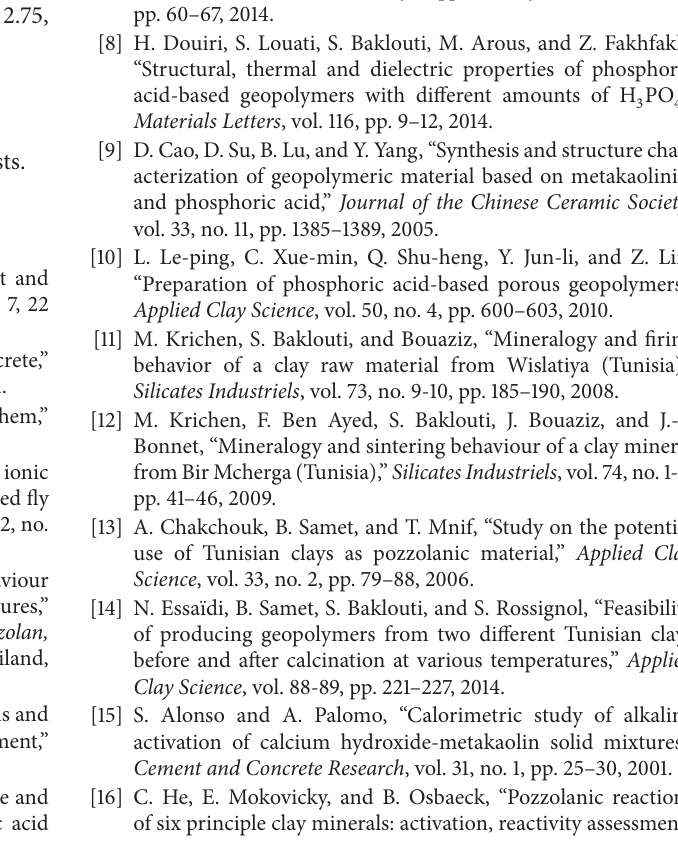
(v) The mechanical strength of geopolymer attains a maximum (37 MPa) for Si/P molar ratio equal to 2.75, which corresponds to a molar ratio Al/P =